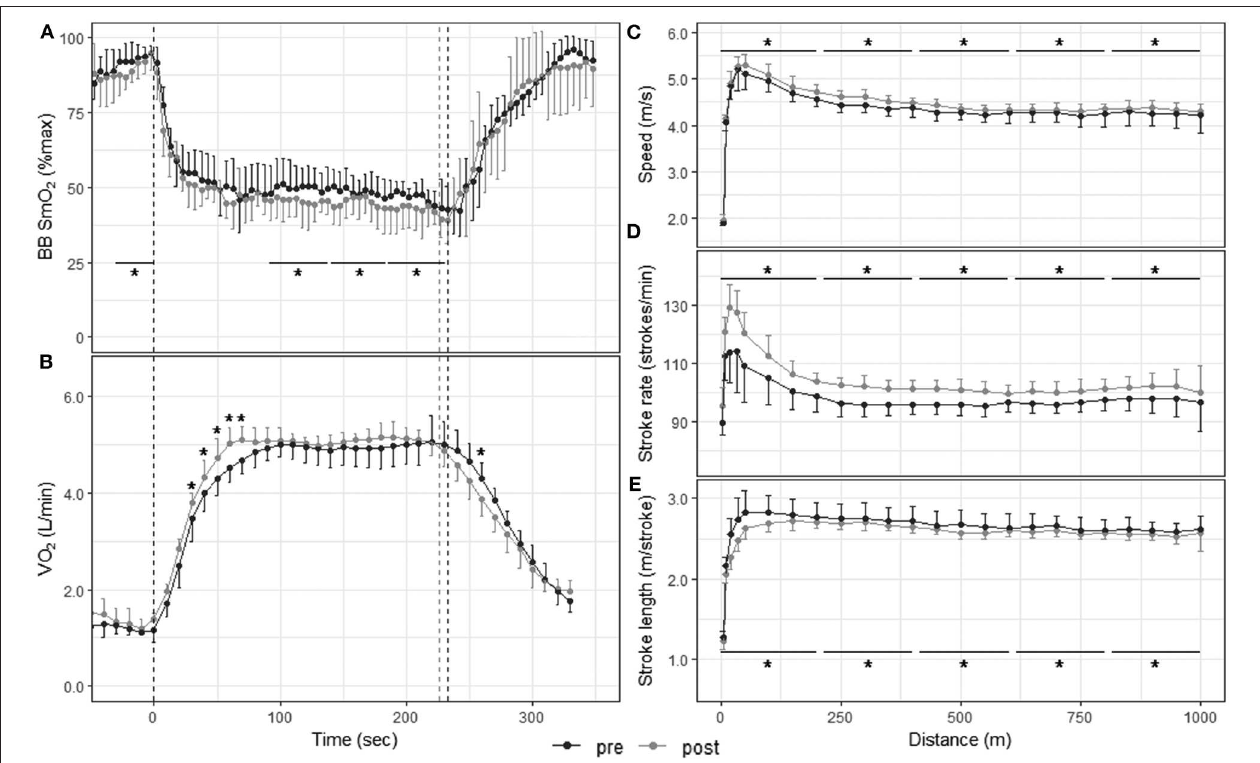
FIGURE 4 | Physiological responses and stroke parameters during the 1,000-m TT before and after the 3-weeks training camp. First vertical dashed line represents the start of the TT; second dashed line represents the end of the TT post training and third dashed line the end of the TT pre-training. * p < 0.05 between pre and post training. (A) Muscle oxygenation in the biceps brachii for 5-s segments 30s before, during, and 120s after the 1,000-m TT; (B) O 2 consumption for 10-s segments 30s before, during, and 120s after the 1,000-m TT; speed (C) , stroke rate (D) , and stroke length (E) for 10-m segments up to 50m and 50-m segments from 50 to